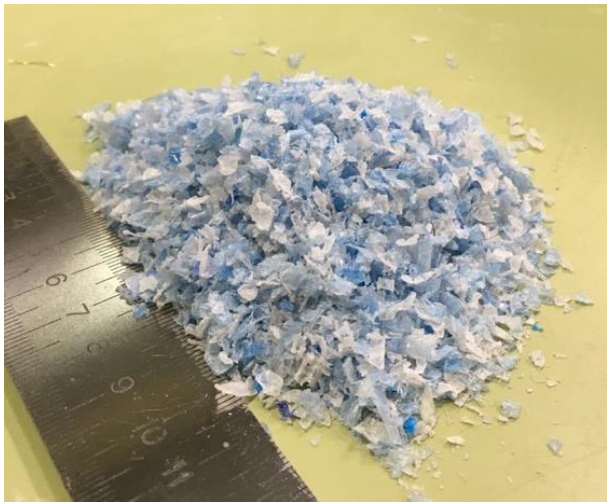
Figure 1. Photo for the shredded PET waste